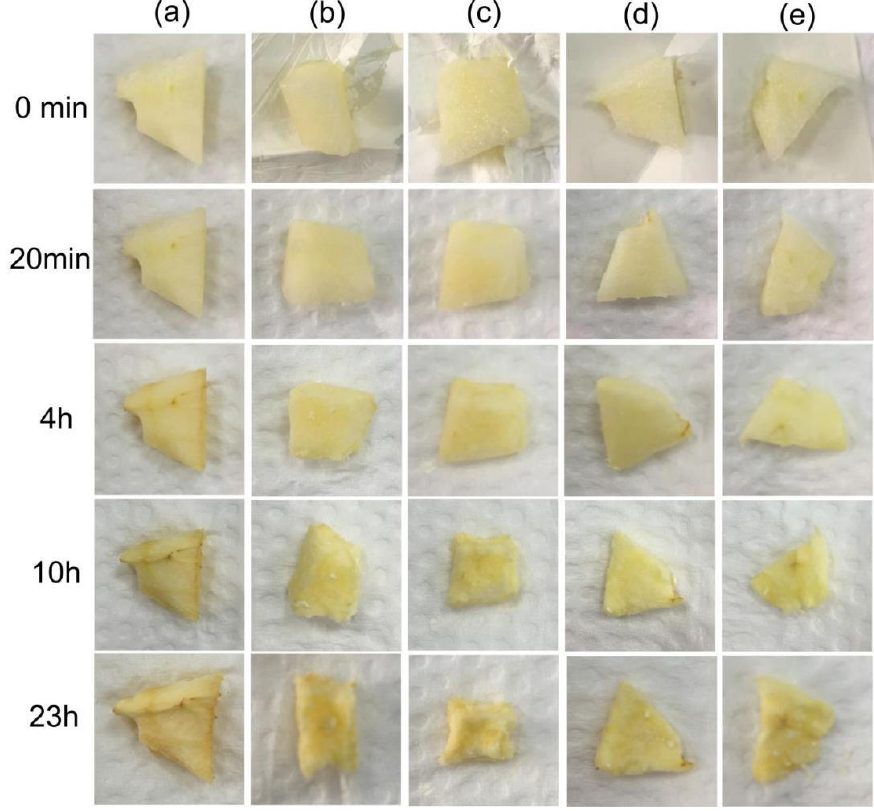
Figure 12. Contact packaging of apple slices and their appearance: ( a ) No fiber packaging; ( b ) F4 packaged group; ( c ) F5 packaged group; ( d ) F6 packaged group; ( e ) F7 packaged group.